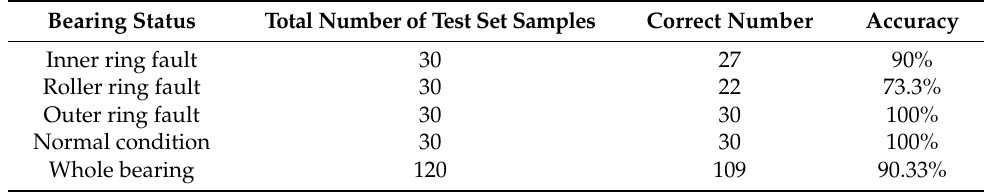
Table 2. Accuracy rate of DBN model with VMD-CMDE as